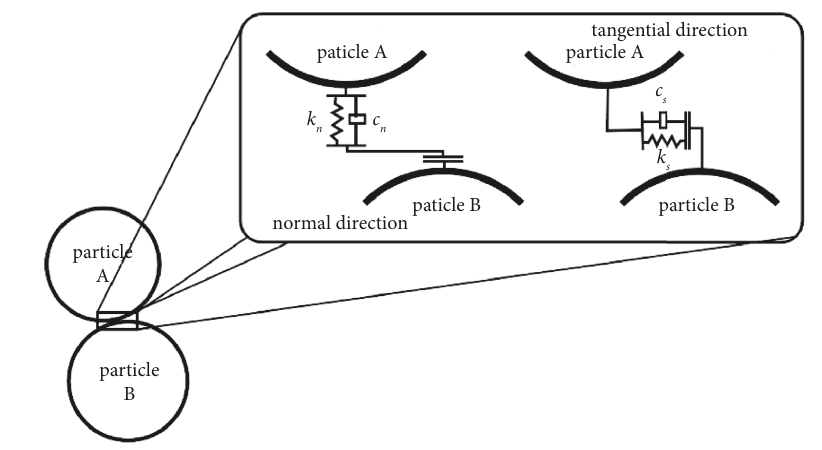
Figure 2: A schematic diagram of the linear contact